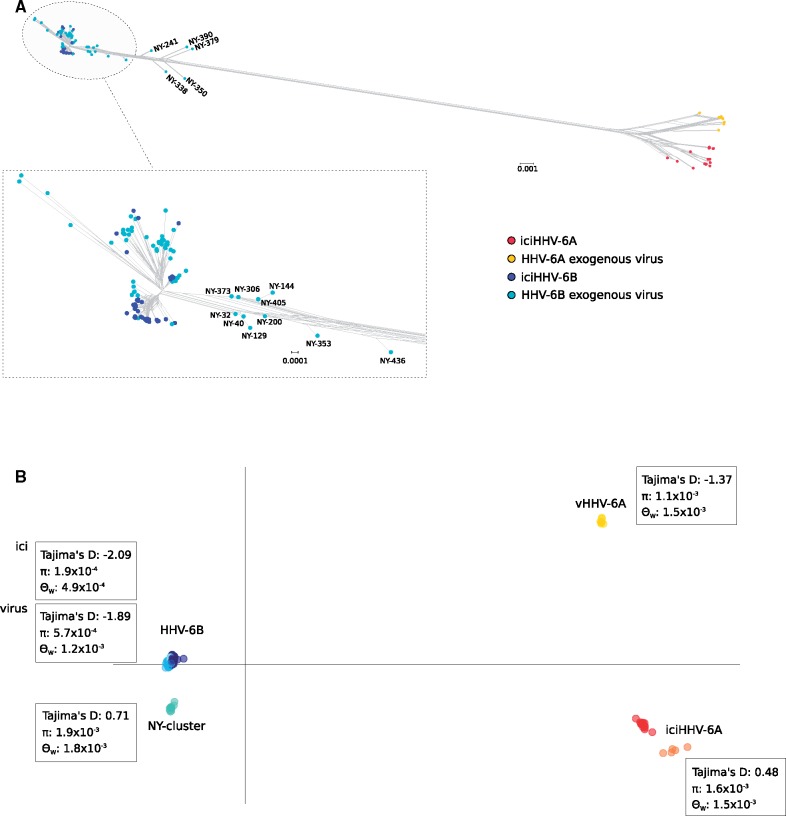
HHV-6 divergence. (A) Neighbor-net split network of 181 HHV-6 genome sequences. Each sample is shown as a dot and colors are indicated in the legend. Divergent HHV-6B exogenous viral sequences sampled in New York state are labeled. (B) DAPC of HHV-6 genomes. The first two discriminants are plotted and samples are colored as in panel A. For each cluster, values of nucleotide diversity (θW, π) and Tajima’s D are also reported. vHHV-6A: HHV-6A exogenous virus; iciHHV-6: inherited chromosomally integrated HHV-6; NY cluster: New York HHV-6B cluster.